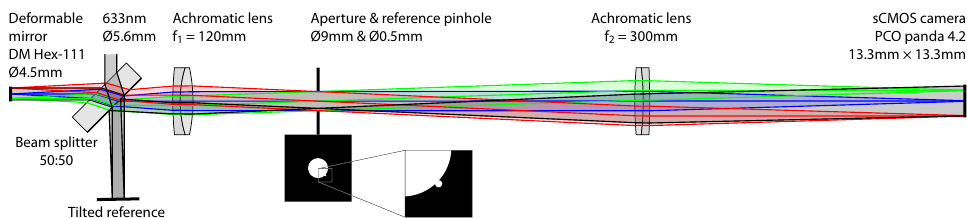
Figure 1. Imaging Michelson interferometer with tilted reference beam for heterodyne phase